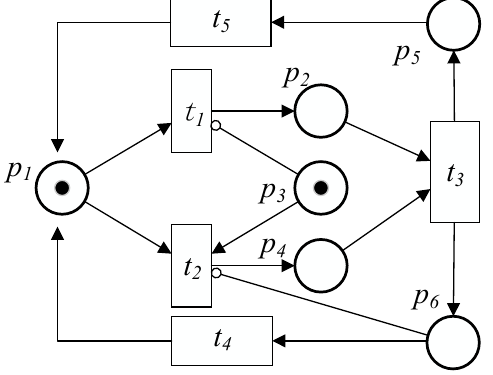
Figure 1. A Petri net with inhibitor